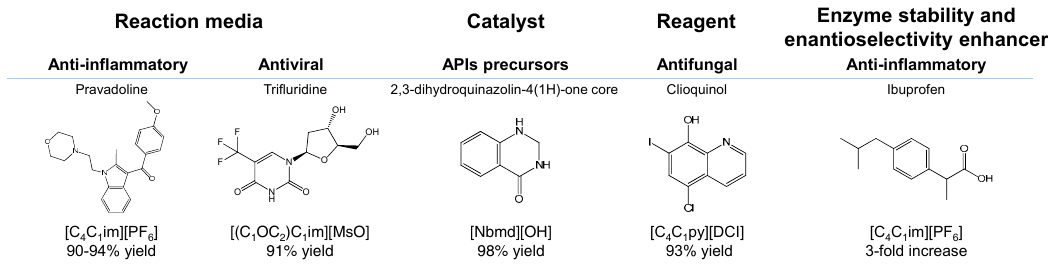
Figure 2. Multiple roles of ILs in the synthesis of different APIs and their respective efficiency (adequate references are given along the current section).